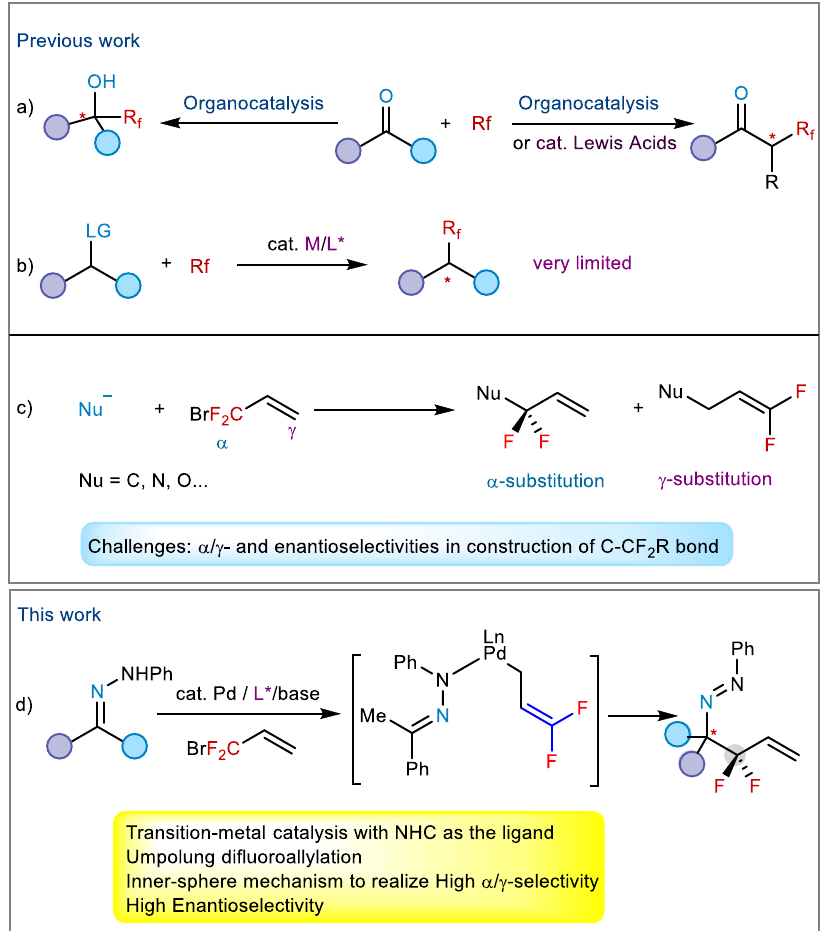
Fig. 2 Asymmetric fl uoroalkylations. a Asymmetric fl uoroalkylation under organocatalysis and Lewis acid catalysis. b Asymmetric fl uoroalkylation under transition-metal catalysis. c Regioselectivity in the reaction of nucleophiles with BDFP. d Palladium-catalyzed umpolung regio- and enantioselective allylation of hydrazones with BDFP. The circles with different color = different